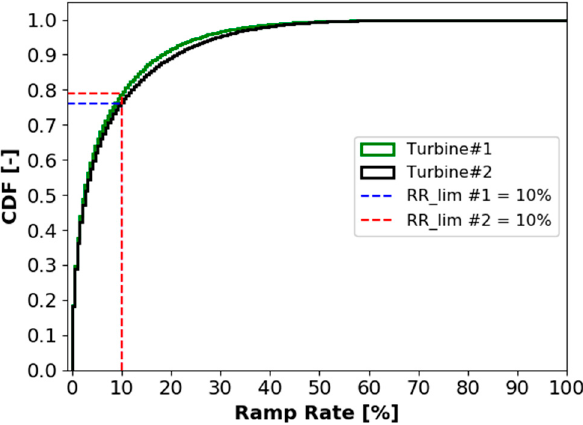
Figure 5. Cumulative Density Functions (CDF) of the 1-min data for WT #1 and #2.